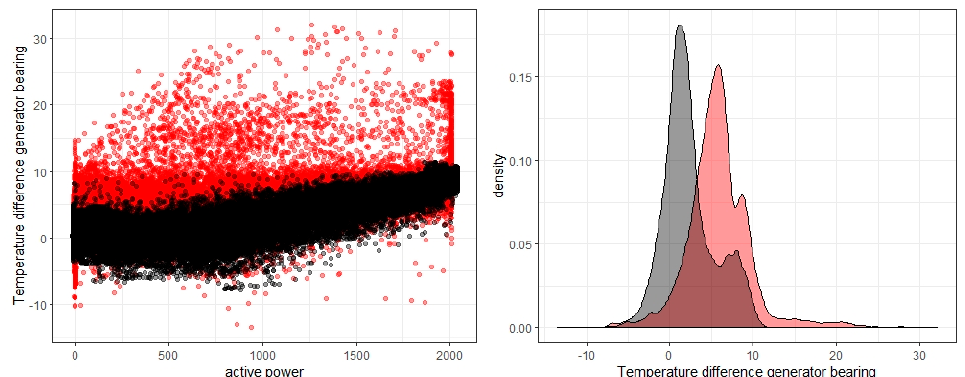
Figure 5. On the left, the characteristic curve that relates the active power and the temperature difference on the two sides of the generator bearing. On the right, the distribution of the probability density function of the temperature difference across the generator bearing. In red, the data belonging to turbine WT09, in black, the mean of the windfarm.